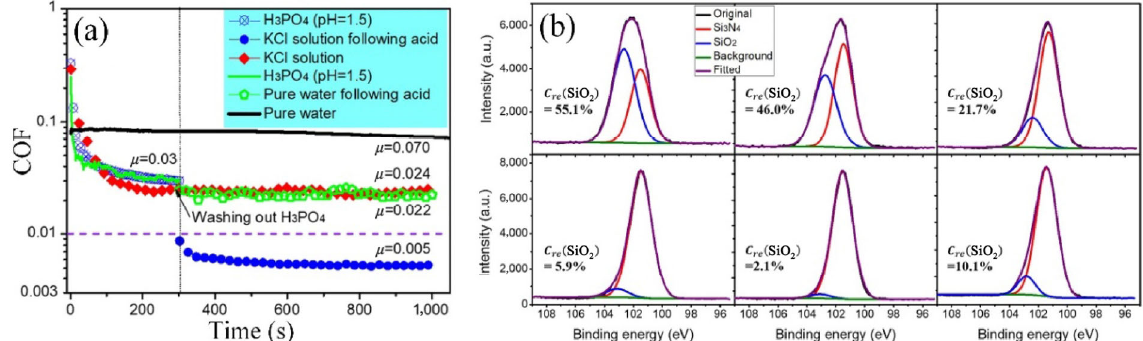
Fig. 9 (a) The stable superlubricity state with a friction coefficient of 0.005 was achieved by using KCl solution between the silicon nitride ball and the sapphire surface, (b) comparison of Si2p peak of XPS on silicon nitride surface after running-in by different solutions. Reproduced with permission from Ref. [80]. © American Chemical Soeity,